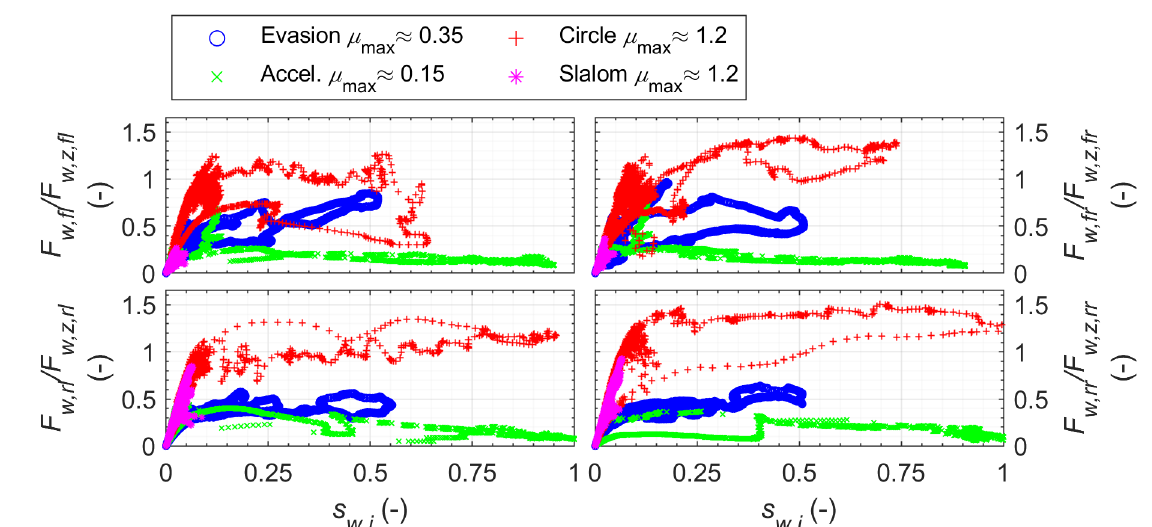
Figure 11. Test data: estimated friction coefficient over tire slip for all driving